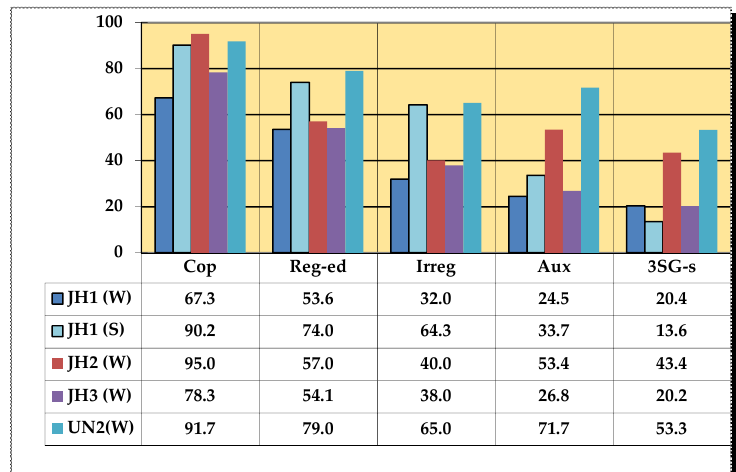
Figure 2. Accuracy rates by participant groups in obligatory affirmative with and without VP − adverb contexts (see Table 6) (%).